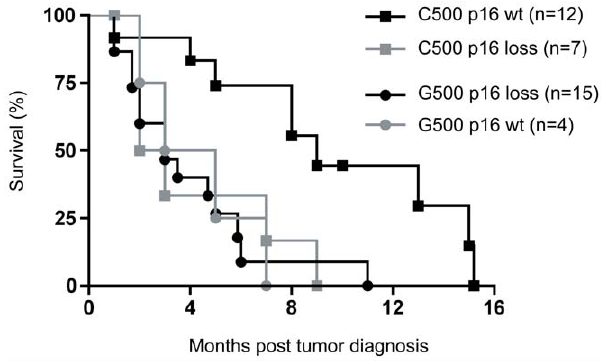
Figure 2. The improved prognosis for C500 homozygotes is associated with retention of p16 INK4a and p14 ARF . Kaplan-Meier survival analysis from Figure 1A with individuals with GBMs with no defined telomere maintenance mechanism further divided on exon 1 a (p16 INK4A ) gene dosage. Individuals homozygous for C500 were divided into those that had loss of homozygosity or loss of heterozygosity (C500 p16 loss) and those that retained exon 1 a homozygosity (C500 p16 wt) by multiplex PCR of tumor DNA. The same division was made for G500 heterozygotes (G500 p16 loss and G500 p16 wt). The C500 p16 loss group had a significantly poorer survival to the C500 p16 wt group (p=0.016, log-rank test with 95% CI). No difference in survival occurred for the G500 p16 loss and G500 p16 wt comparison. All associations for p16 INK4a pertained to p14 ARF due to identical exon 1 a and exon 1 b gene dosage.